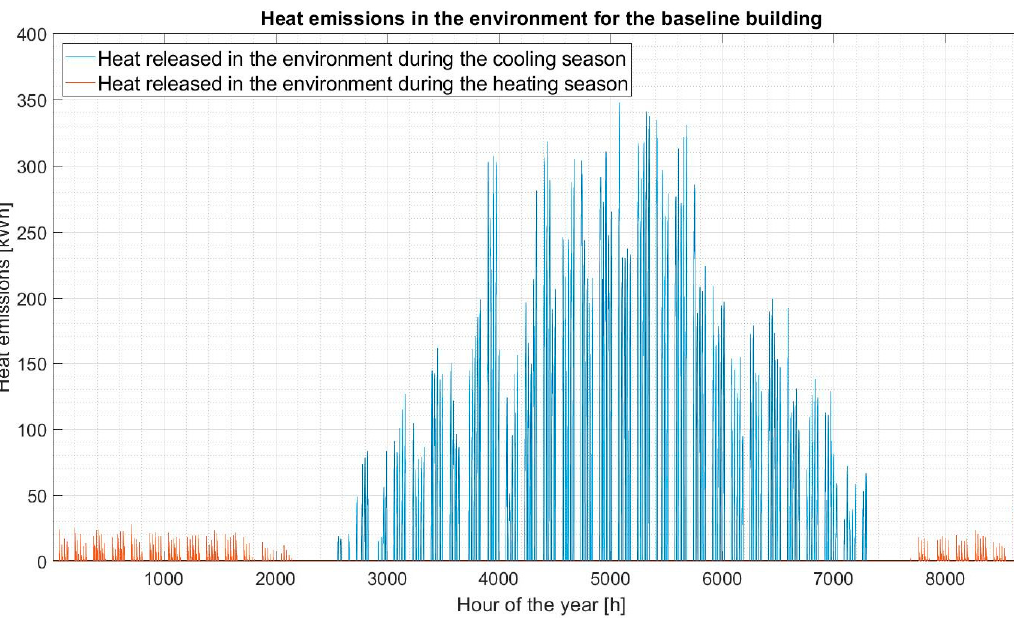
Figure 5. Heat emissions into the external environment for the baseline situation.